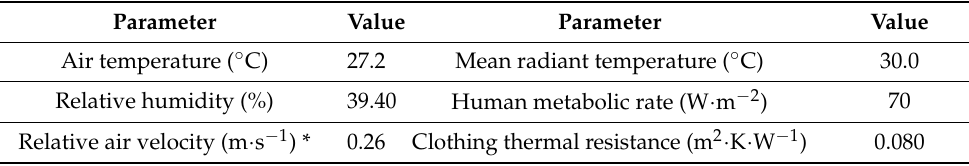
Table 6. Basic parameters calculated using PMV. Parameter Value Parameter Value Air temperature ( ◦ C) 27.2 Mean radiant temperature ( ◦ C) 30.0 Relative humidity (%) 39.40 Human metabolic rate (W · m − 2 ) 70 Relative air velocity (m · s − 1 )